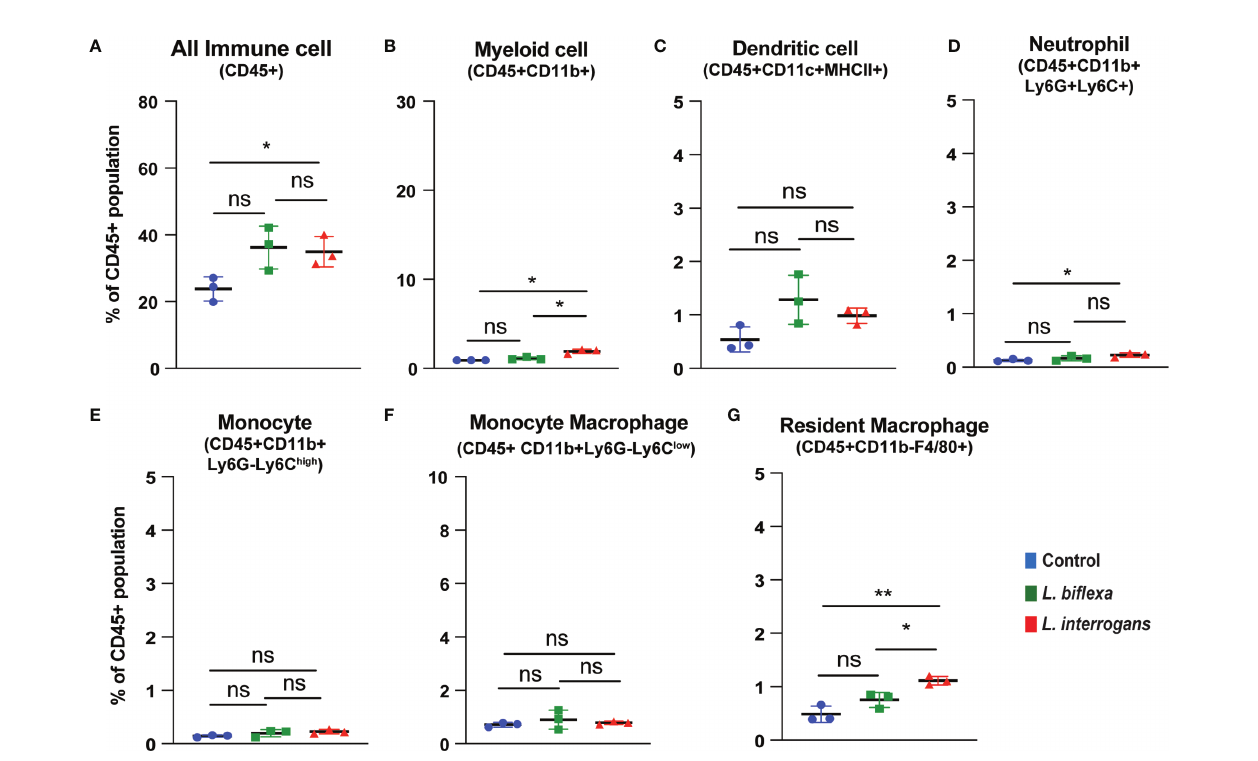
FIGURE 4 | Necroptotic cell death among different immune cells in spleen at 72h post infection. Annexin V + /PI + cells were considered as zone of necroptosis in (A) All Immune Cells, (B) Myeloid cell, (C) Dendritic cell, (D) Neutrophil, (E) Monocyte, (F) Monocyte-Macrophage and (G) Resident Macrophage. Plots are represented as % of CD45+ population. Statistical analysis was performed using unpaired student t-test with Welch ’ s correction, *p < 0.05, **p < 0.01; n = 3 mice per group. Data represents one of two independent experiments; N= 7 mice per group. ns, not-signi fi